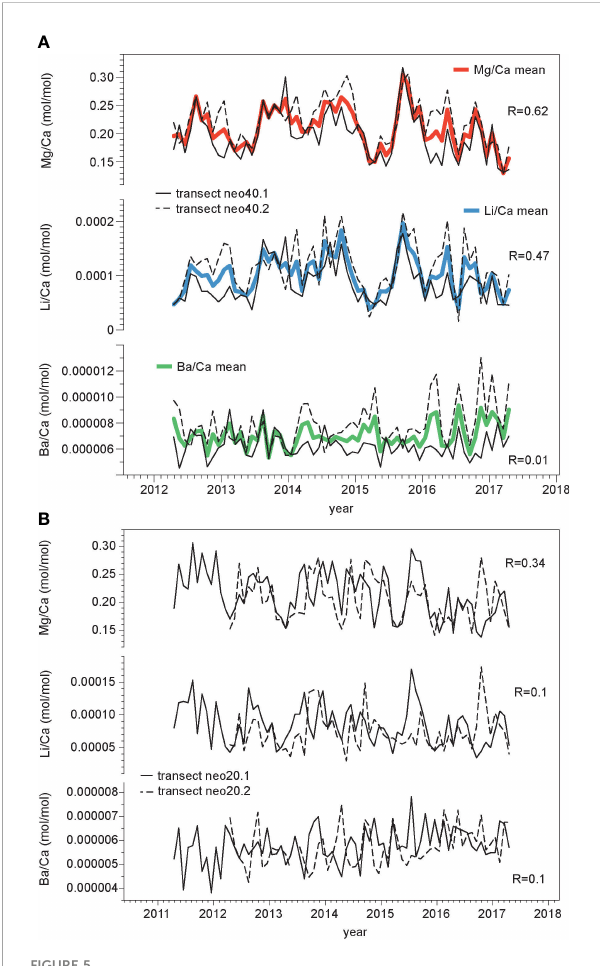
FIGURE 5 Age models for element/Ca ratios and intraspecimen variability. Changes in the Mg/Ca, Li/Ca, and Ba/Ca ratios (monthly resolution) shown over time; (A) sample neo40 - solid lines: transect neo40.1; stippled lines: transect neo40.2; bold lines: mean of both transects. (B) sample neo20 - solid lines: transect neo20.1; stippled lines: transect neo20.2. Note that due to low correlation and placement of transects on separate protuberances no means were calculated for sample neo20. Correlation coef fi cients are shown for comparisons between transects for each element/Ca ratio, respectively